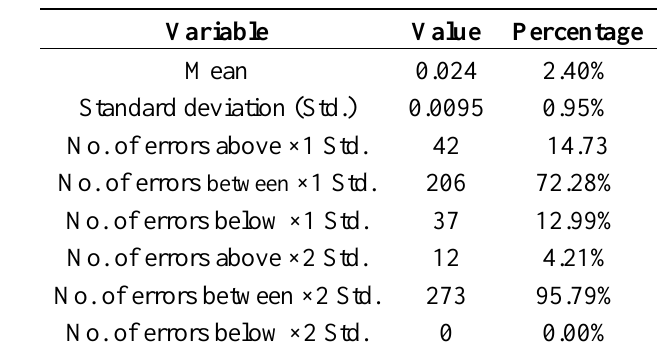
Table 1. Error distribution per